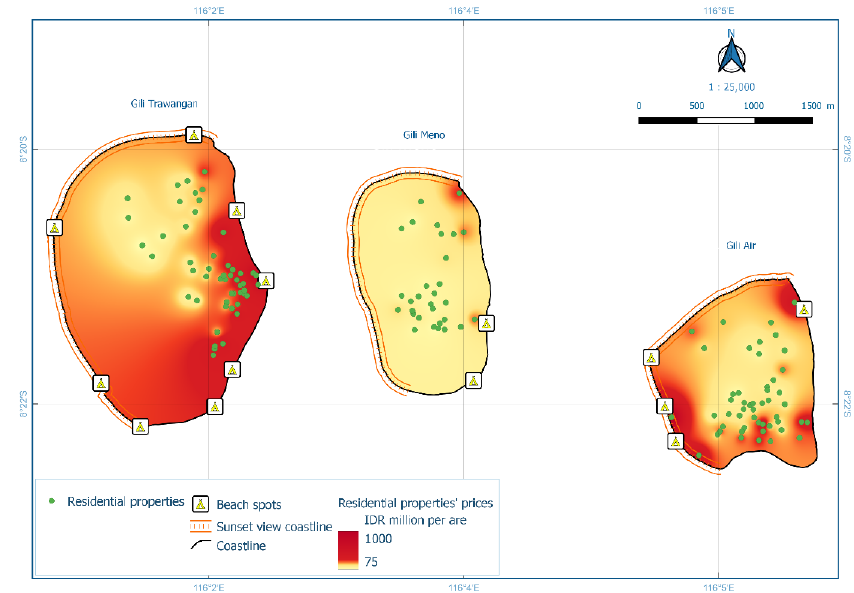
Figure 5. Interpolation of residential property prices for Gili Matra Islands (Model